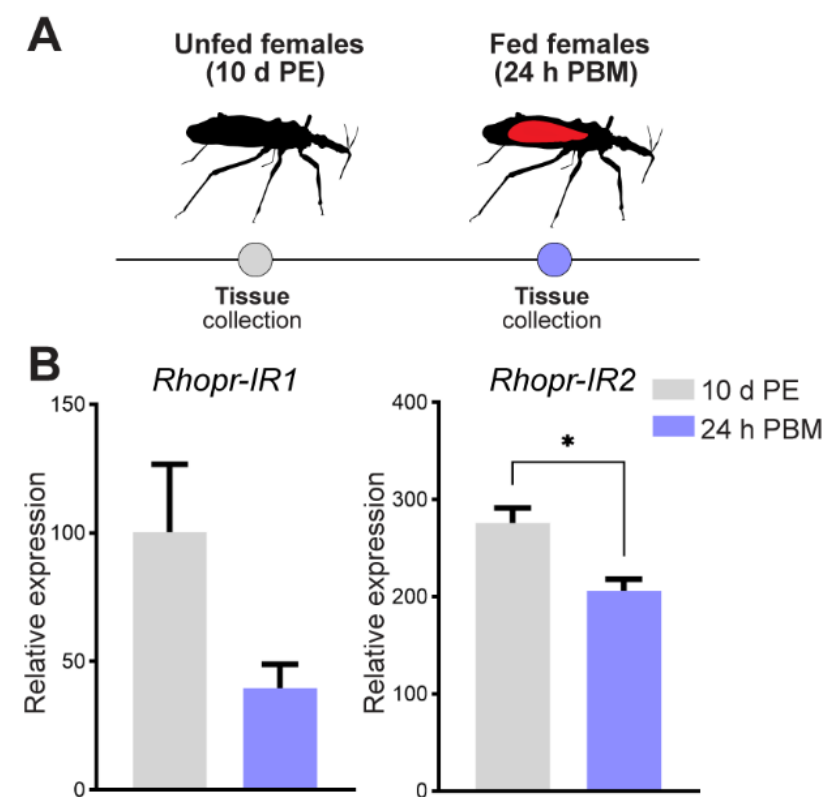
Figure 3. Transcript expression of insulin receptors in the CC-CA of R. prolixus in different nutritional states. ( A ) Scheme of tissue collection. ( B ) Transcript levels of Rhopr-IR1 ( left ) and Rhopr-IR2 ( right ) were quantified in the CC-CA complexes obtained from unfed (10 d PE) and fed (24 h PBM) females using RT-qPCR. The analysis was performed using the 2 − ∆ Ct method. The y-axes represent the relative expression obtained via geometric averaging using Rp49 and actin as reference genes. The results are shown as the mean ± SEM ( n = 5, where each n represents a pool of CC-CA complexes from 3 insects). * p < 0.05; (Student’s t -test). d PE, days post ecdysis; h PBM, hours post blood meal.